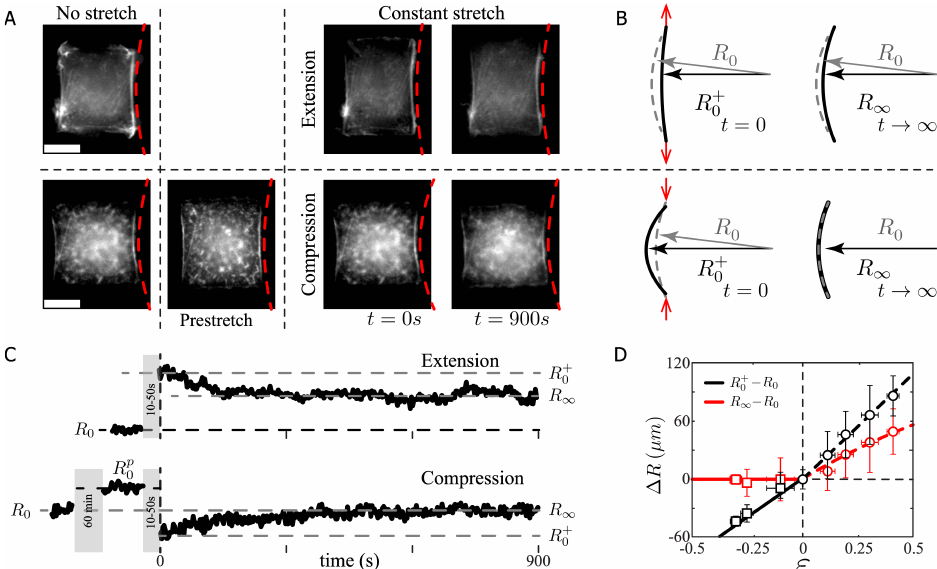
Figure 2. Radius of curvature of SFs vs. the applied strain. ( A ) Two examples of RPE-1 cells plated on H-like patterns before and during the applied stretch. Scale bar 20 µ m. ( B ) Sketch of the SF and the definition of the radius of curvature. ( C ) Response of the radius of curvature as a function of time for extension and compression conditions. Note that the initial radius of curvature for compression experiments corresponds to a prestretched state with initial radius R p , whereas R + and 0 0 R ∞ correspond to the radii just after stretch and after fifteen minutes of constant stretch, respectively. The gray region represents the delay on the observation due to the stretching process at a velocity of 100 µ m/s. ( D ) Radius of curvature difference at short and long time scale (circles and squares symbols) for extension and compression experiments. N = 12 SF for each data point. Notice that the error bars amplitude, in all plots, correspond to the standard deviation (SD); therefore, the uncertainty √ N of the data correspond to the SD value divided by